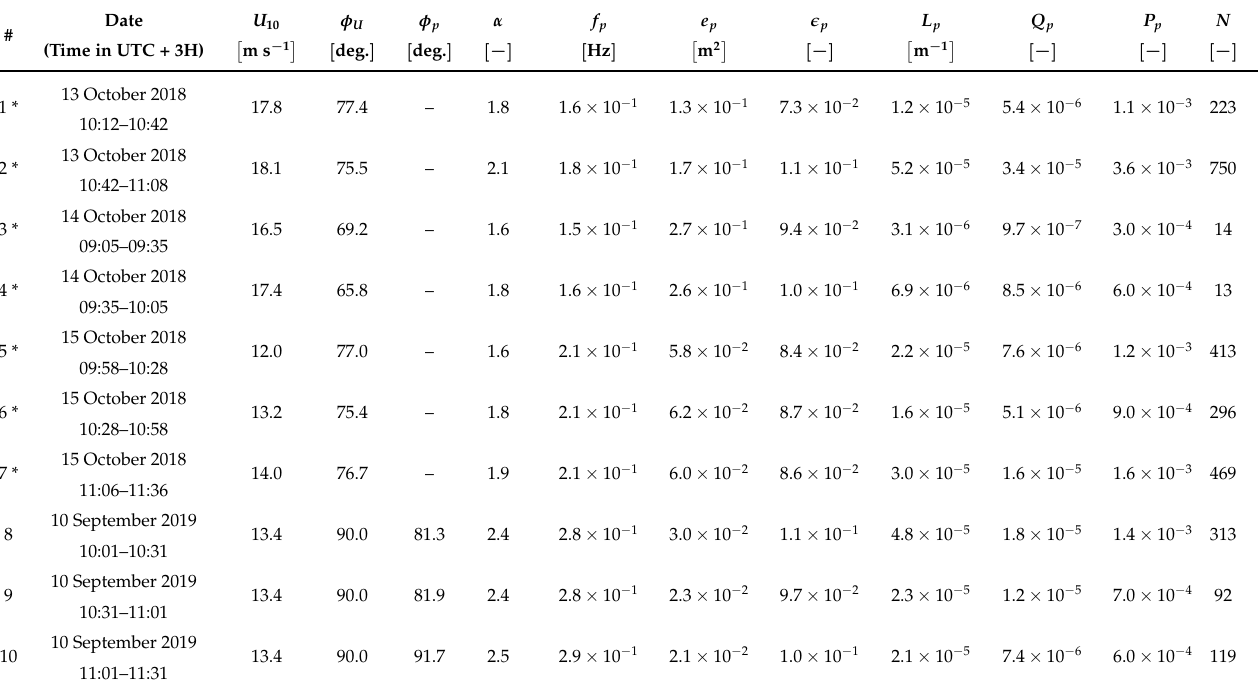
Figure 6. ( top ) Wind speed, U 10 and direction, φ U time series for a video record in the onshore-wind conditions. ( bottom ) The same, but in the offshore-wind conditions. Black lines are 15-min-average wind speed. Black vertical thick lines indicate time intervals of continuous video recordings of the sea surface. Shaded gray rectangles indicate time intervals, for which the wave spectra and statistical wave breaking parameters of dominant waves were estimated and shown in Figure 2. Table 1. Wind data, wave and wave breaking parameters of dominant wind-waves in the onshore-wind conditions. In the table, U 10 and φ U is the wind speed and direction at 10 m height, φ p is the wave propagation direction, α is the inverse wave age, f p , e p , (cid:101) p are the frequency, energy and steepness of dominant waves, L p and Q p are the total length of whitecaps per unit surface area and the active whitecap coverage of dominant waves, respectively, P p is the dominant wave breaking probability and N is the number of breaking events of dominant